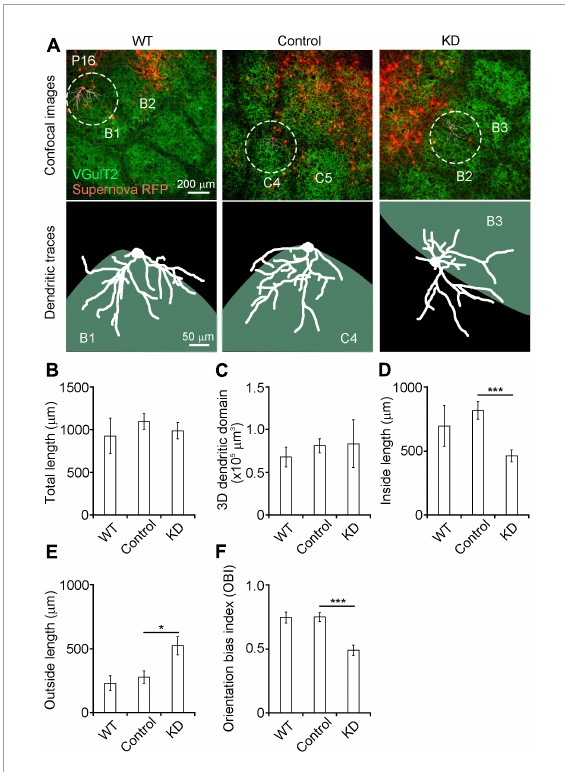
FIGURE2 (A) Dendritic orientation was impaired in RasGAP-suppressed neurons Top images: confocal images obtained from P16 mice (left: wild-type, middle: RNAi control; right RasGAP knockdown). Bottom images: dendritic tracings of Supernova RFP-labeled L4 neurons. (B–F) Quantitative analysis of dendritic morphology (WT, 7 cells from 5 mice; control, 12 cells from 8 mice; KD, 13 cells from 6 mice). The orientation bias index was calculated by dividing the inside dendritic length by the total dendritic length. * p < 0.05, *** p < 0.001.